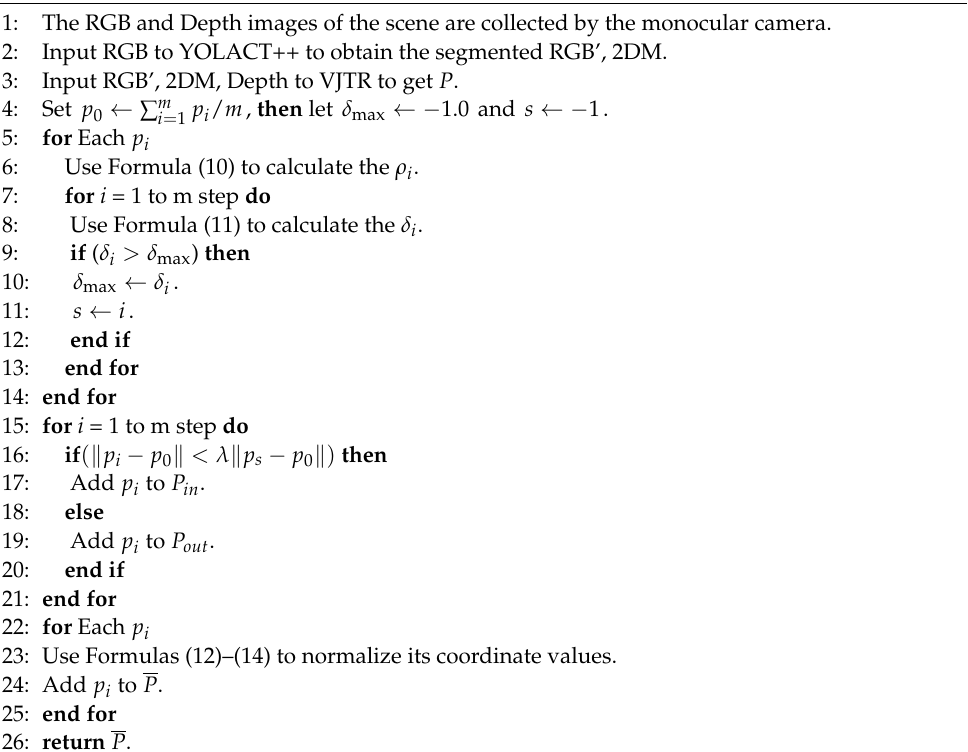
Algorithm 1. The process of the real-time 3D reconstruction